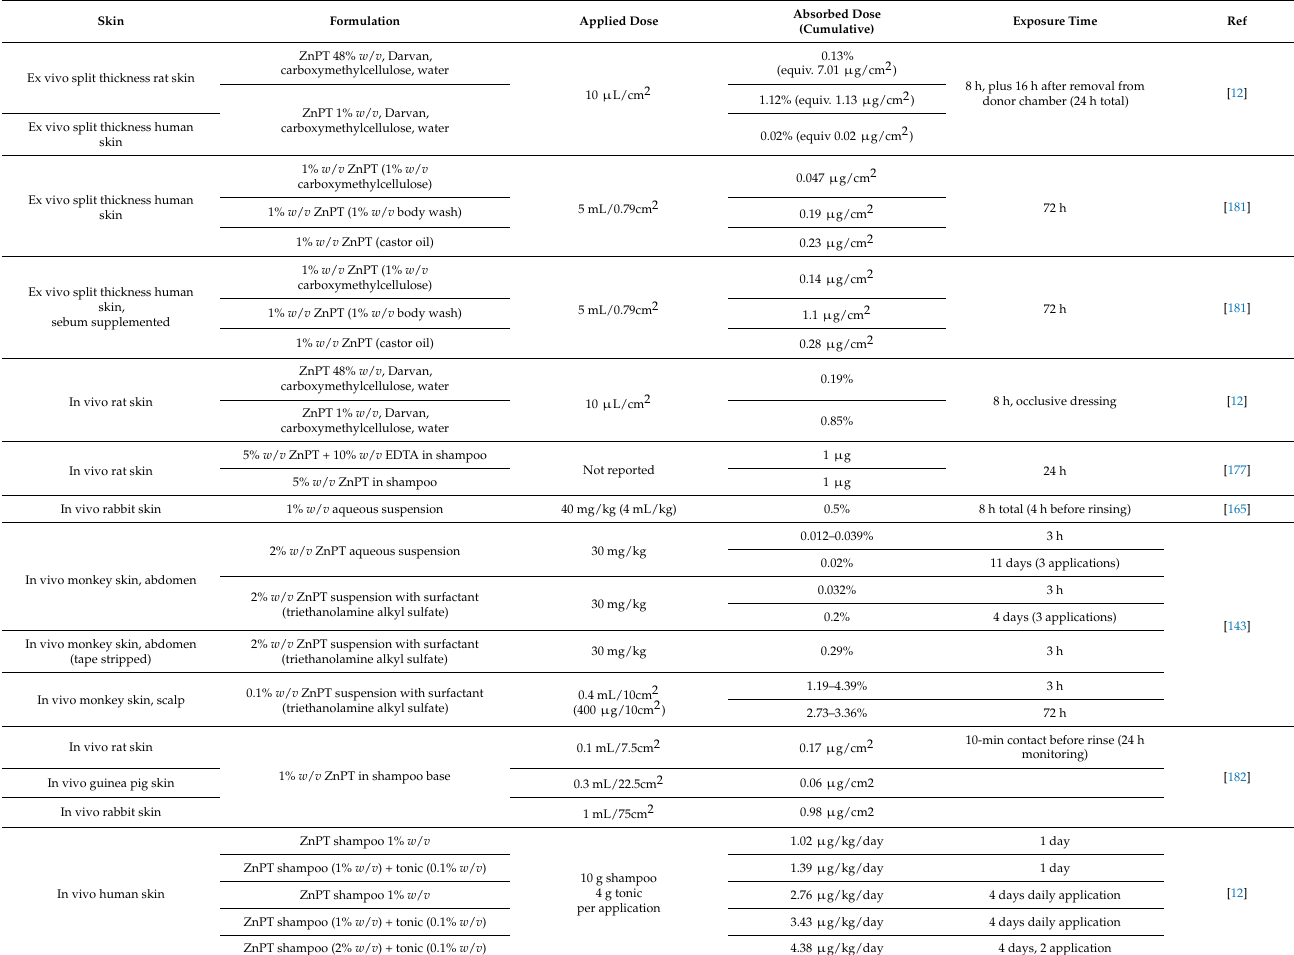
Table 4. Human and animal systemic exposure values for zinc pyrithione applied in various